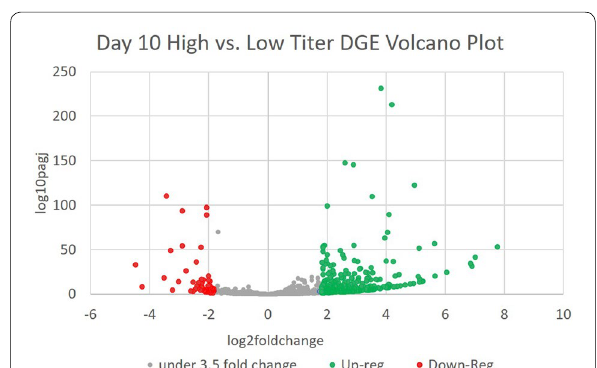
Fig. 5 Volcano plot representing differential gene expression of 204 and 205 ( AA) when compared to BR 202 and 203 (no AA). Green + encircled dots in the represent the 489 total upregulated genes in V204 and V205 (with a fold change cut-off of 3.5 with p-adj < 0.005), while red encircled dots represent the 67 total downregulated genes with the same cut-off